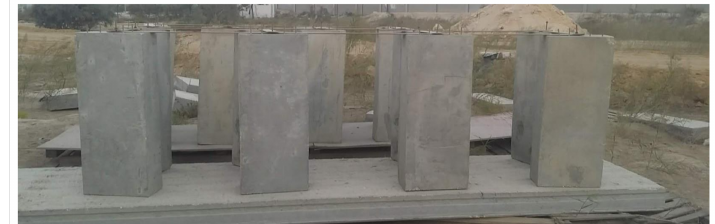
Figure 2. Concrete blocks setup in the coastal zone, with the proper bracing on top and isolation from